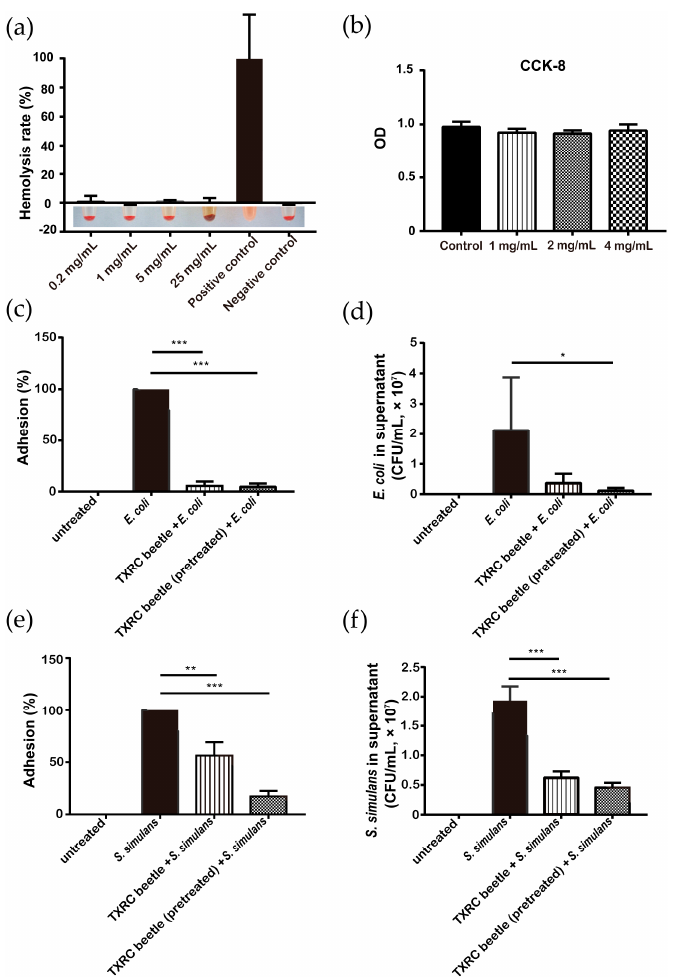
Figure 4. Z. morio hemolymph does not induce hemolysis and inhibits pathogens adhesion to MAC-T cells. ( a ) Erythrocytes were diluted to 2% in PBS buffer and incubated with various concentrations of Z. morio hemolymph for 2 h at 37 °C, and hemolysis rate was determined. ( b ) MAC-T cells (5000 cells/well) were incubated with various concentrations of Z. morio hemolymph, and cell pyroptosis was detected by the Cell Counting Kit-8 (CCK-8) assay 2 h later. ( c , e ) Adhesion assay of bacteria with MAC-T cells. ( c ) MAC-T cells (3 × 10 5 cells/well) were either untreated or treated alone with E. coli (3 × 10 7 CFU), treated with E. coli (3 × 10 7 CFU) and Z. morio hemolymph (2 mg/mL) simultaneously (TXRC beetle + E. coli ), and pretreated with Z. morio hemolymph (2 mg/mL) for 1 h and then followed by E. coli (3 × 10 7 CFU). The percentage of adhesions of each group was accessed 2 h later. ( e ) Similar to ( c ), except that S. simulans was used instead of E. coli and the concentration of Z. morio hemolymph was 4 mg/mL. ( d , f ) CFU detection in co-cultured supernatants. ( d ) Similar to ( c ), except the CFU in supernatant was detected. ( f ) Similar to ( e ), except the CFU in supernatant was detected. For all panels, XTRC beetle stands for Z. morio hemolymph in this figure. These experiments were carried out in triplicate and the results are expressed as the mean ± SD. * p < 0.05, ** p < 0.01, *** p < 0.001.